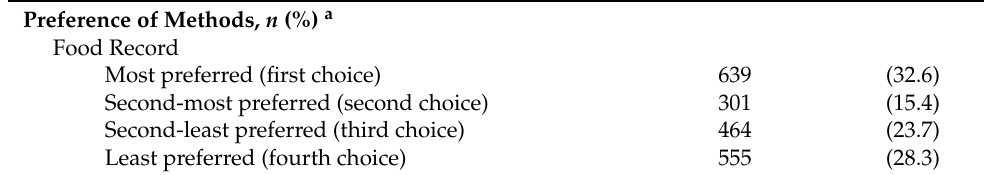
Figure 2. Percentage of participants who rated each method as their preferred method of food intake assessment (Panel A ) and who rated the expected burden of each method as low (Panel B ). * Denotes a significant difference in ‘not preferred’ (Panel A ) and in ‘high expected burden’ (Panel B ) for the respective method ( p < 0.001) in the same panel. Letters (a–d) that differ from each other indicate differences between methods ( p < 0.001) in the same panel. RFPM, Remote Food Photography Method. Table 3. Preference, expected burden, and willingness to use the four methods of food intake assessment (N = Preference of Methods, n (%) a